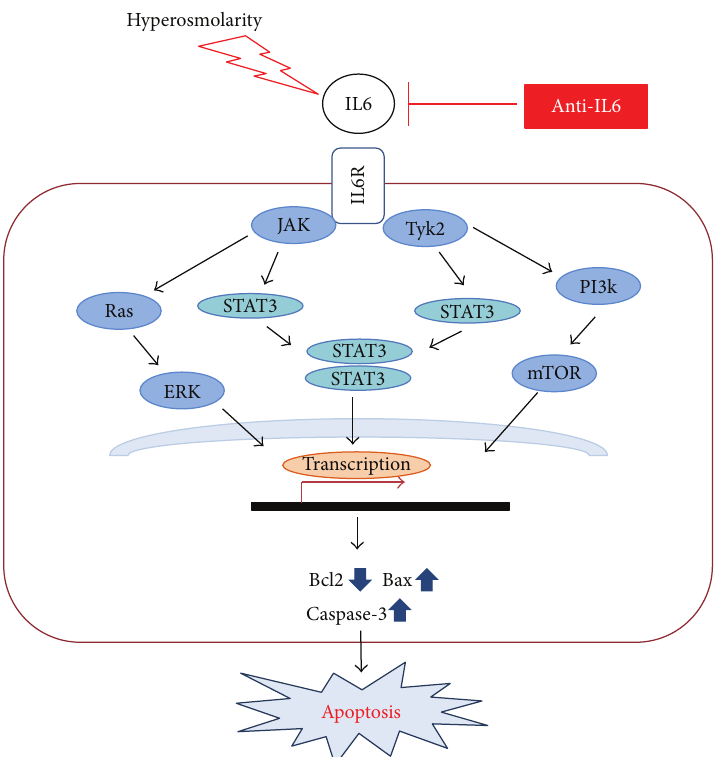
Figure4:TheroleofIL6inducedbyhyperosmolarity.HyperosmolarityinducedtheexpressionofIL6followedbyapoptosis,whereasblocking IL6 suppressed JAK-STAT signaling and